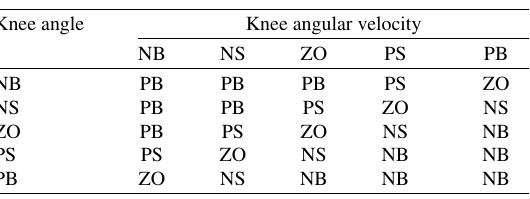
Table 3 Rule base of the fuzzy